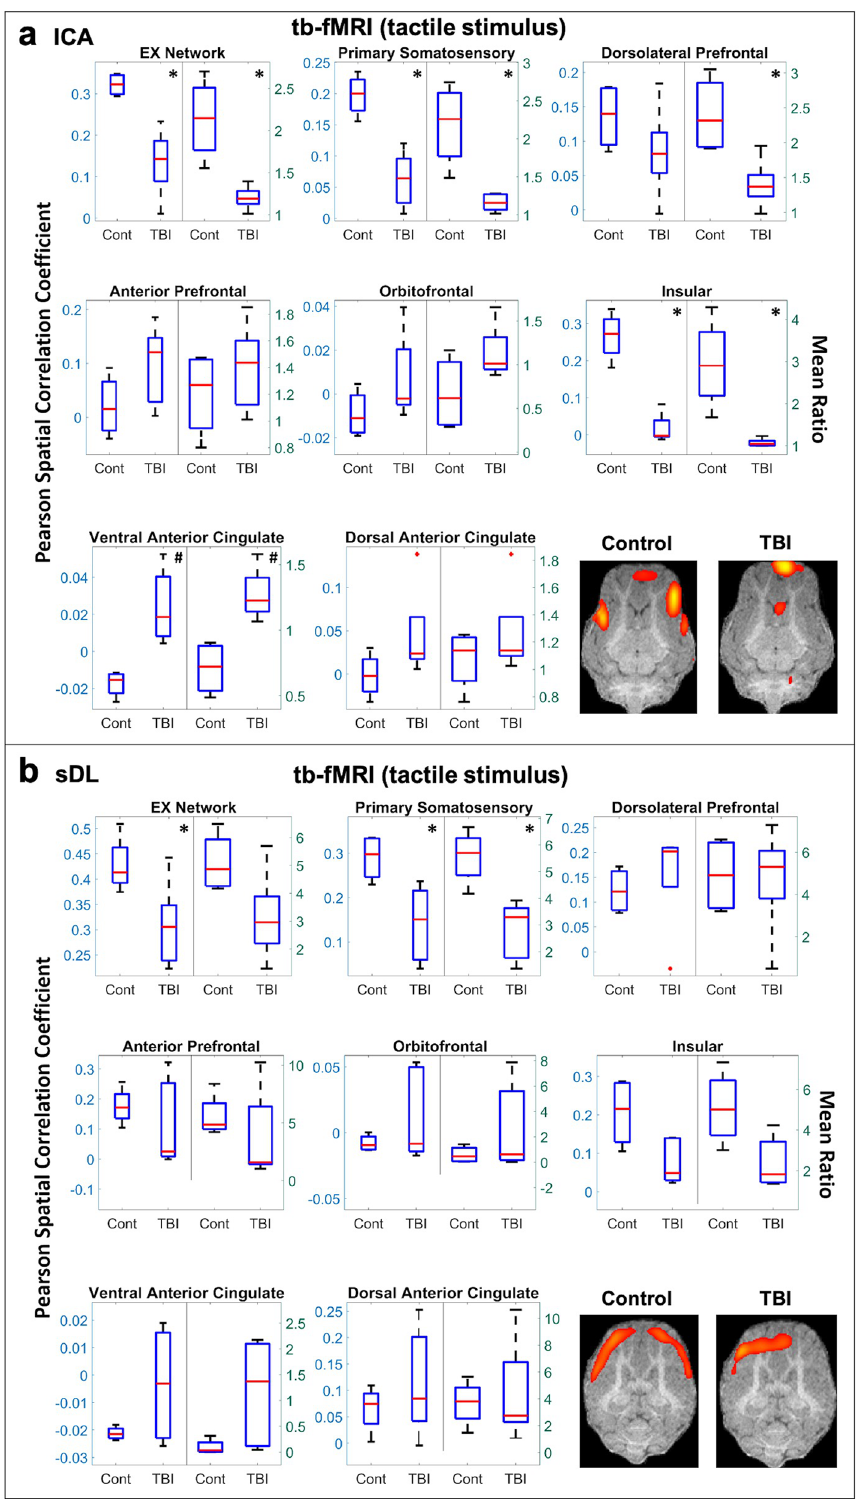
Figure 4. Task-based (tb-) tactile stimulus analysis of the executive control (EX) network. Boxplots of Pearson spatial correlation coefficients (left) and mean ratios (right) obtained from the tb- analysis for the EX network and its individual anatomical regions obtained using independent component analysis (ICA; a ) and sparse dictionary learning (sDL; b ). The red line denotes the median, the blue box denotes the interquartile range, and the lower and upper whiskers denote the min and max, respectively. An asterisk (*) or pound (#) in the upper right-hand corner indicates significant decrease or increase (p < 0.05), respectively, for the TBI group in comparison to the control group. Representative coronal plane activation maps overlaid on the template pigs’ T1-weighted anatomical image are also displayed. Representative maps in the axial and sagittal plane are provided in the Figures S4 and